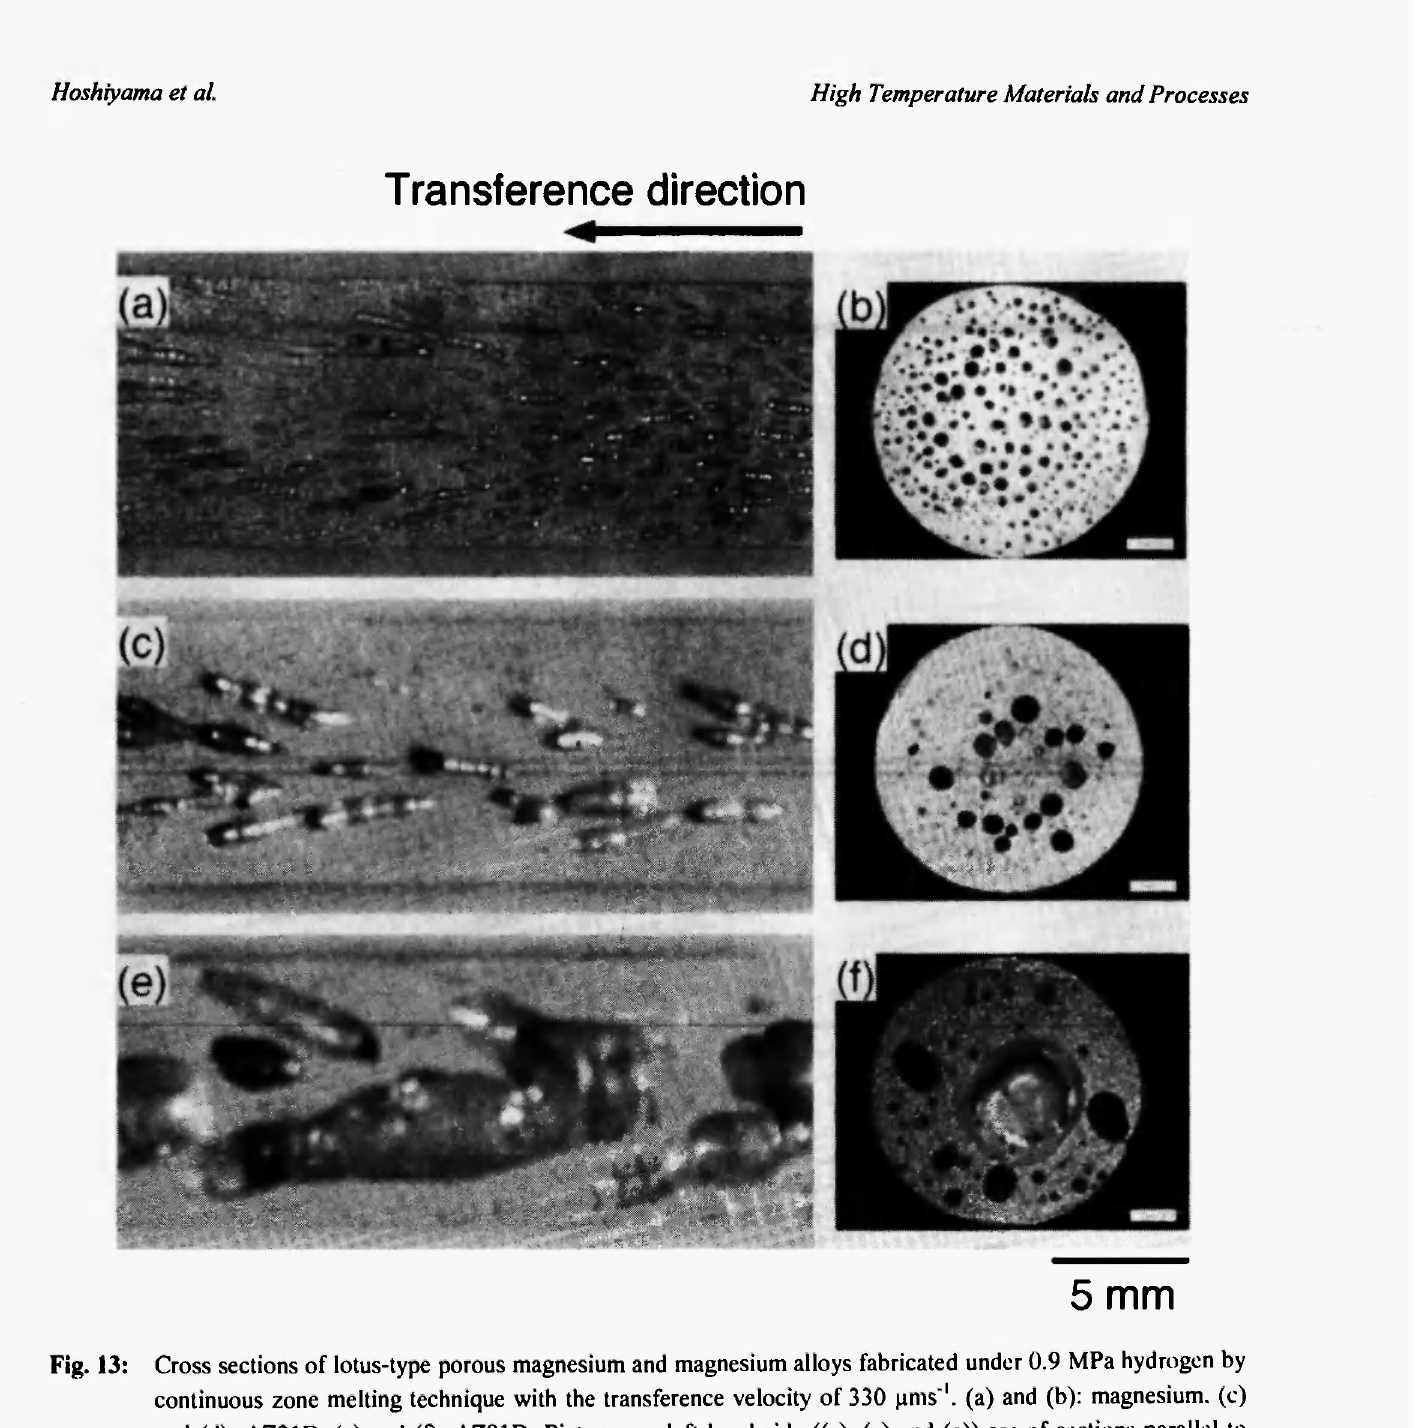
solidification direction easier, as considered in Fig. 12. One of the merits of the continuous zone melting technique is that the temperature gradient can be controlled by controlling the power for blowing of ambient gas just below the melt zone. Figure 15 shows